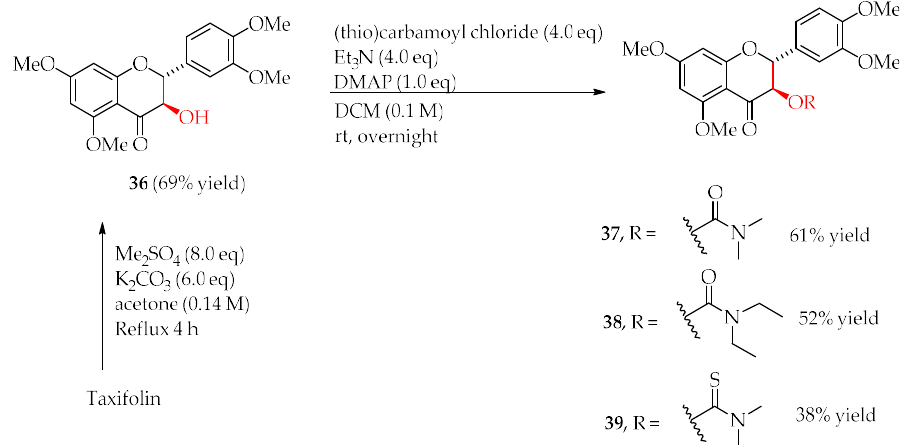
Figure 5. Chemical structures of taxifolins.